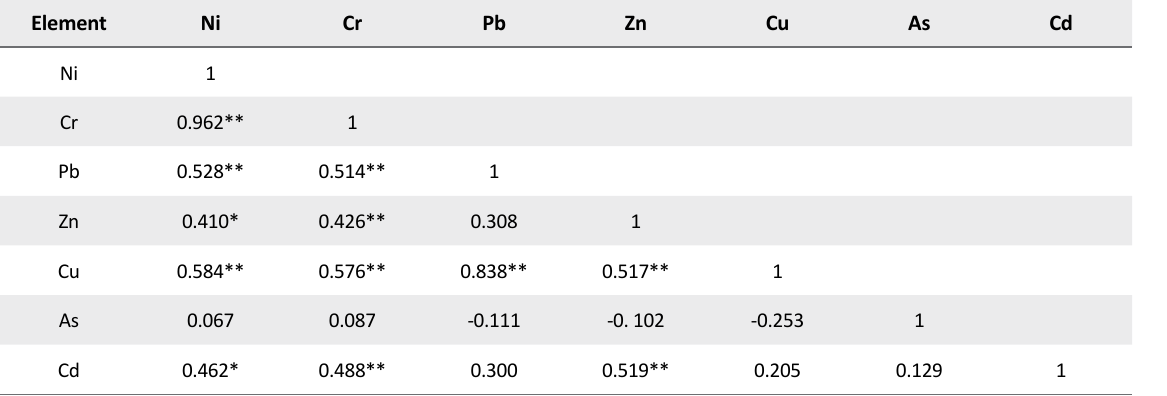
*Correlation at 5% level, **Correlation at 1% level.